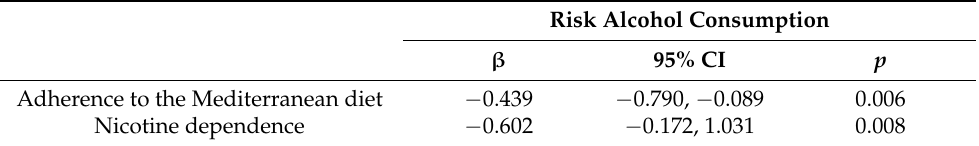
Table 4. Associations between adherence to the Mediterranean diet, nicotine dependence, and risk alcohol